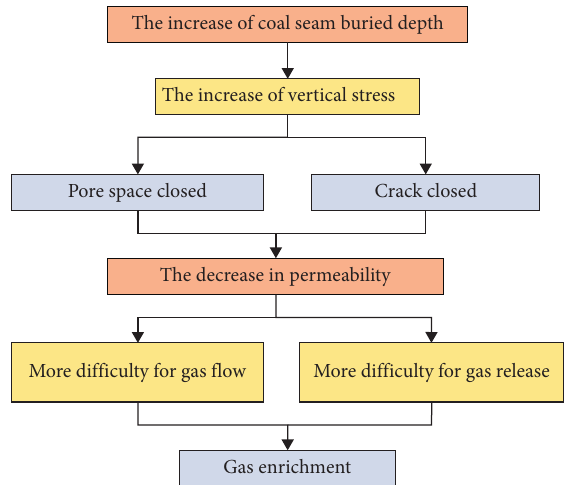
Figure 1: The relationship between burial depth, stress, perme- ability, and gas enrichment.